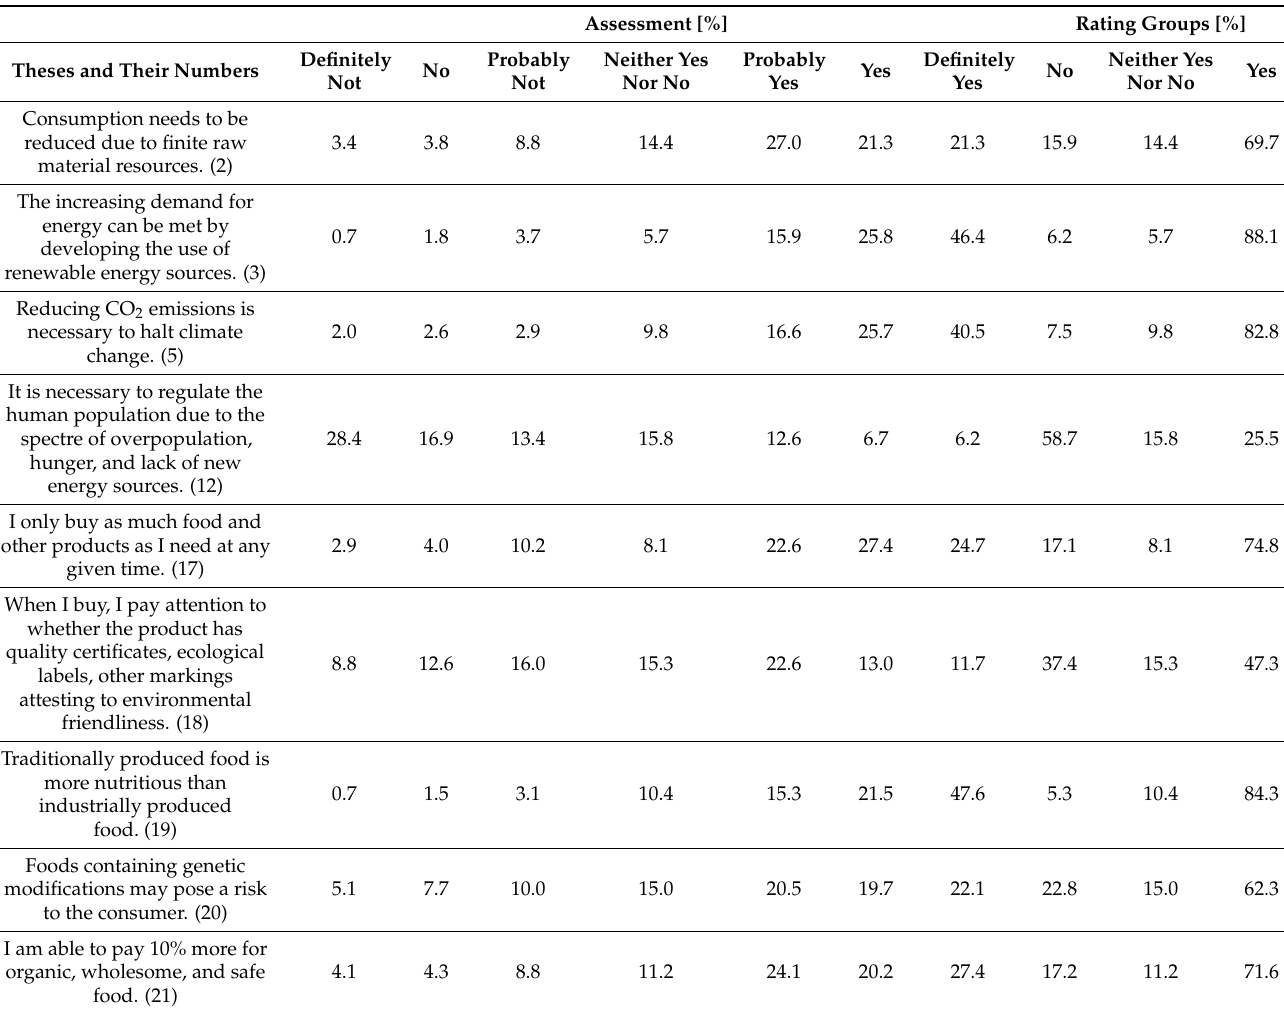
Table 7. The structure of evaluations of phrases representing issues related to the ecological attitude and purchasing attitude using a seven-point bipolar scale and a group of evaluations according to the direction of assessment (own